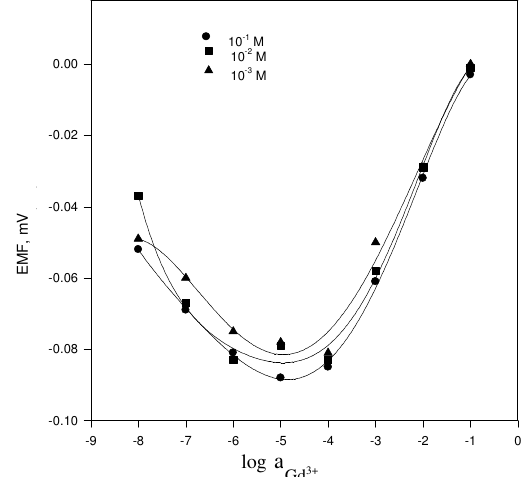
Figure 1(a). Curves for Gd(III) selective electrode (40% membrane) based on ZrWP in epoxy resin and also the effect of internal solution.